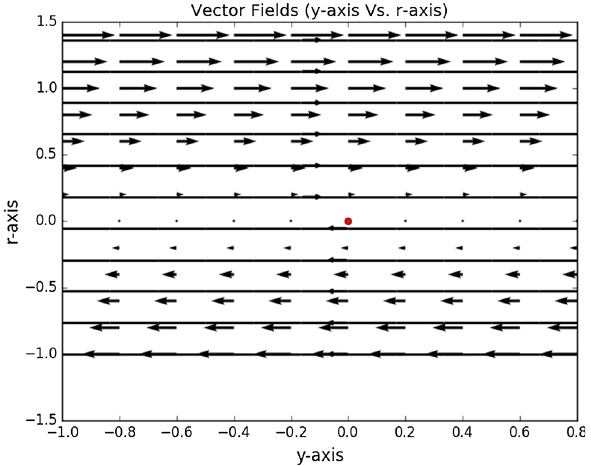
Fig. 1 H c = 0 and v 0 = 0